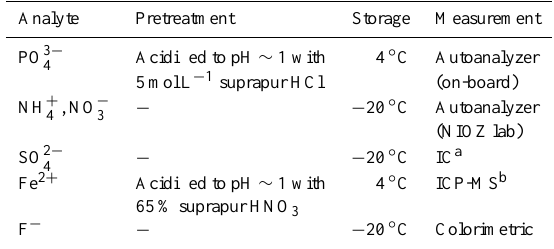
Table 2. Pore-water sub sample treatment and analysis. Analyte Pretreatment Storage Measurement PO 3 − 4 Acidified to pH ∼ 1 with 4 ◦ C Autoanalyzer 5molL − 1 suprapur HCl (on-board) NH + 4 , NO − 3 Autoanalyzer (NIOZ lab) Acidified to pH ∼ 1